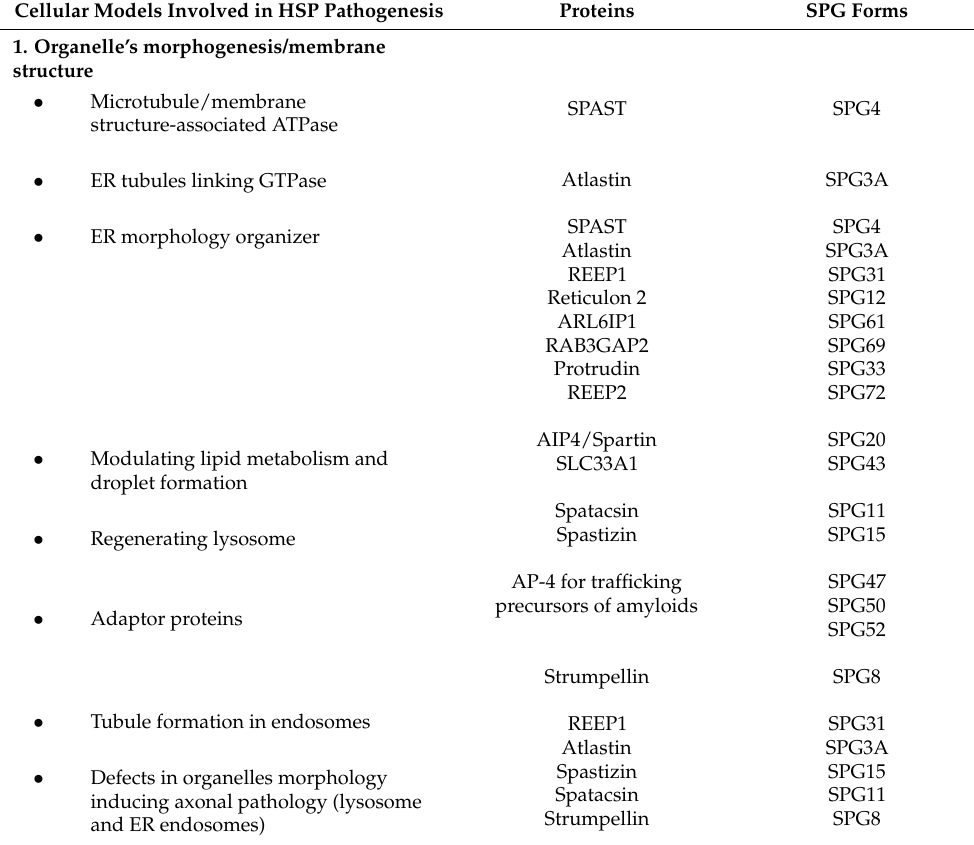
Table 4. Cellular models are involved in the pathogenesis of HSP, including the genes involved and HSP subtypes in each